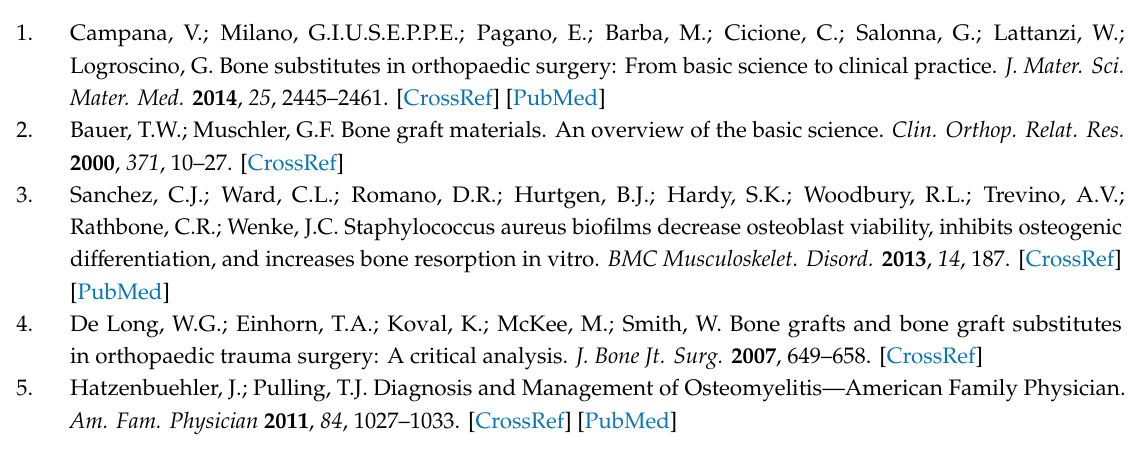
Figure S1: Contact angle at each layer modification; Figure S2: The SEM images and EDS element analysis for 3D printed sca ff old; Figure S3: Deposition of Na for each step modification.; Figure S4: Cell adhesion on surface that with each layer modification; Figure S5: Picro-sirius Red Stain for type I (yellow) and type III (red) collagen that are synthesized at bottom layer of 3D sca ff olds with di ff erent time incubation. Arrows point to type I collagen; Figure S6: Picro-sirius Red Stain for type I (yellow) and type III (red) collagen that are synthesized at inner space of 3D sca ff olds with di ff erent time incubation. Arrows point to type I collagen; Figure S7: ARS stain for calcium deposition with cells cultured in regular 2D environment (control) and 3D sca ff olds. The red color represents calcium